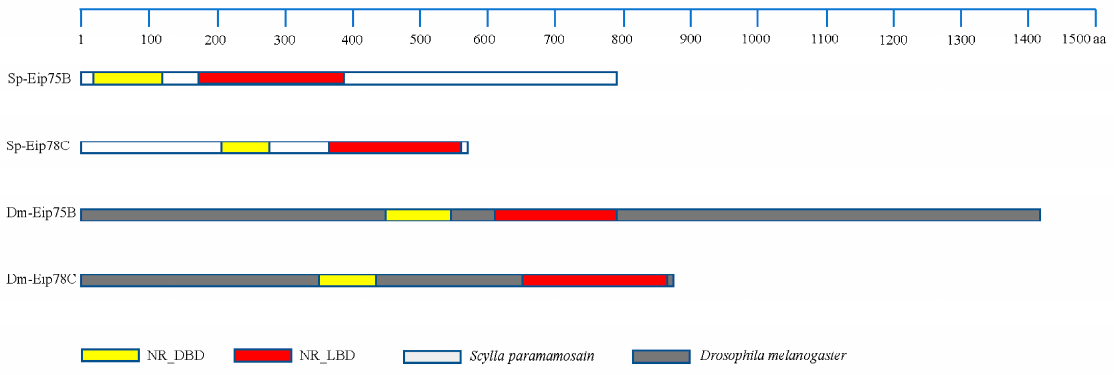
Figure 7. Domain architectures of the PPAR γ -homologs, Eip75B and Eip 78C, in Drosophila melano- gaster and S. paramamosain . Sp-Eip75B/78C : ecdysone-induced protein E75B/78C in S. paramamosain ; Dm-Eip75B/78C: ecdysone-induced protein E75B/E78C in Drosophila melanogaster . NR_LBD: Lig- and-binding domain (LBD) of nuclear receptor (NR); NR_DBD: DNA binding domain (DBD) of nuclear receptor (NR).